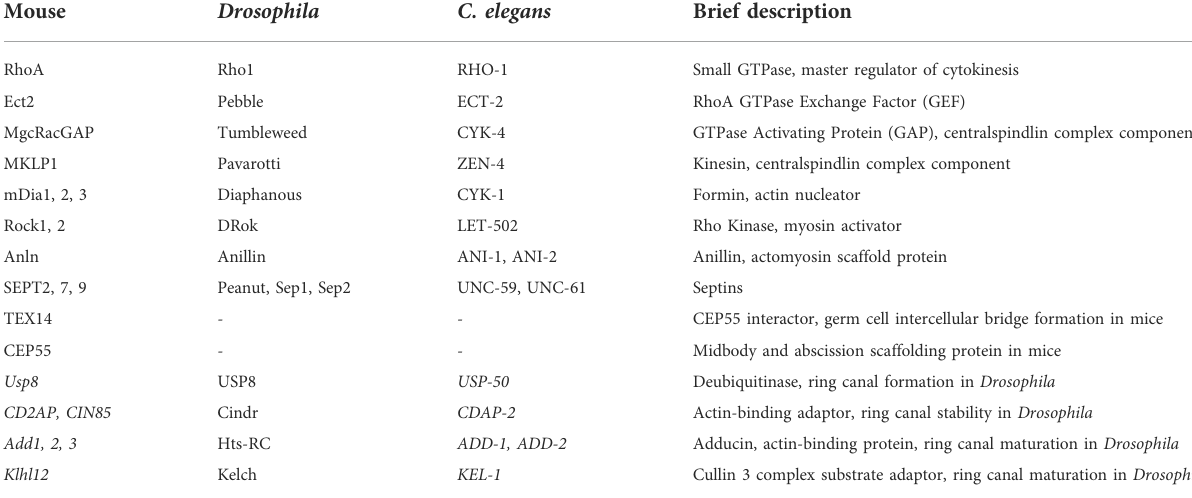
TABLE 1 Regulators of cytokinesis and/or germ cell intercellular bridge formation a .